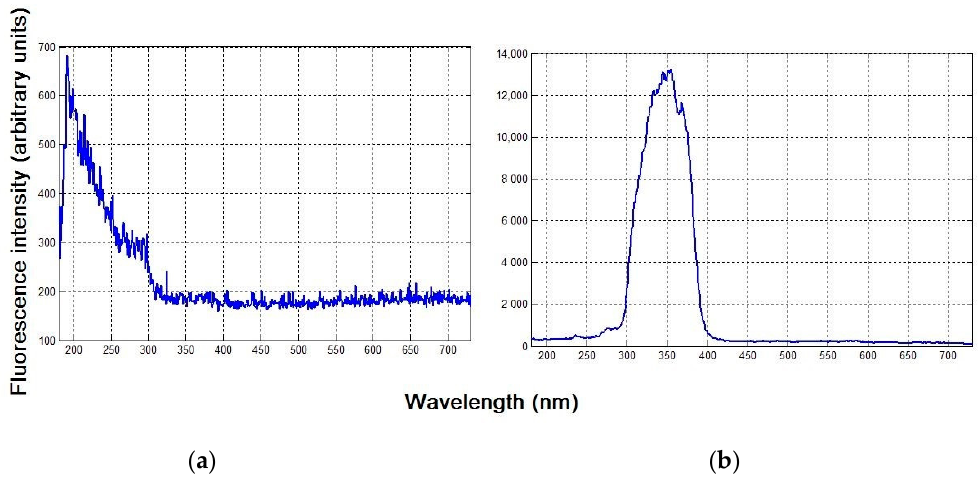
Figure 4. Fluorescence spectra of clean seawater: ( a ) without and ( b ) with the sensor’s FFS.